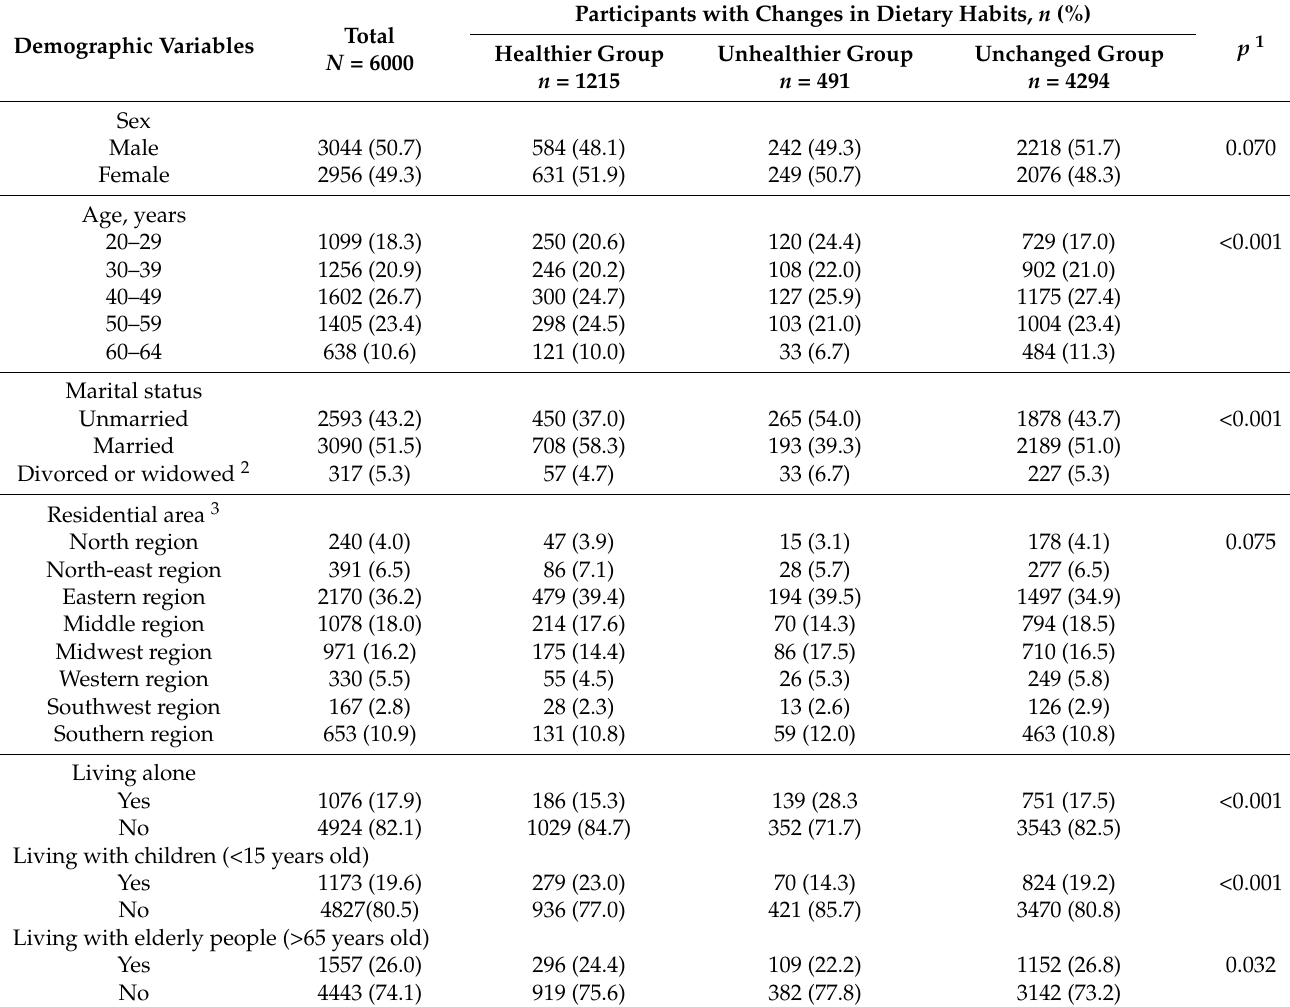
Table 1. Comparison of demographic variables among the healthier, unhealthier, and unchanged